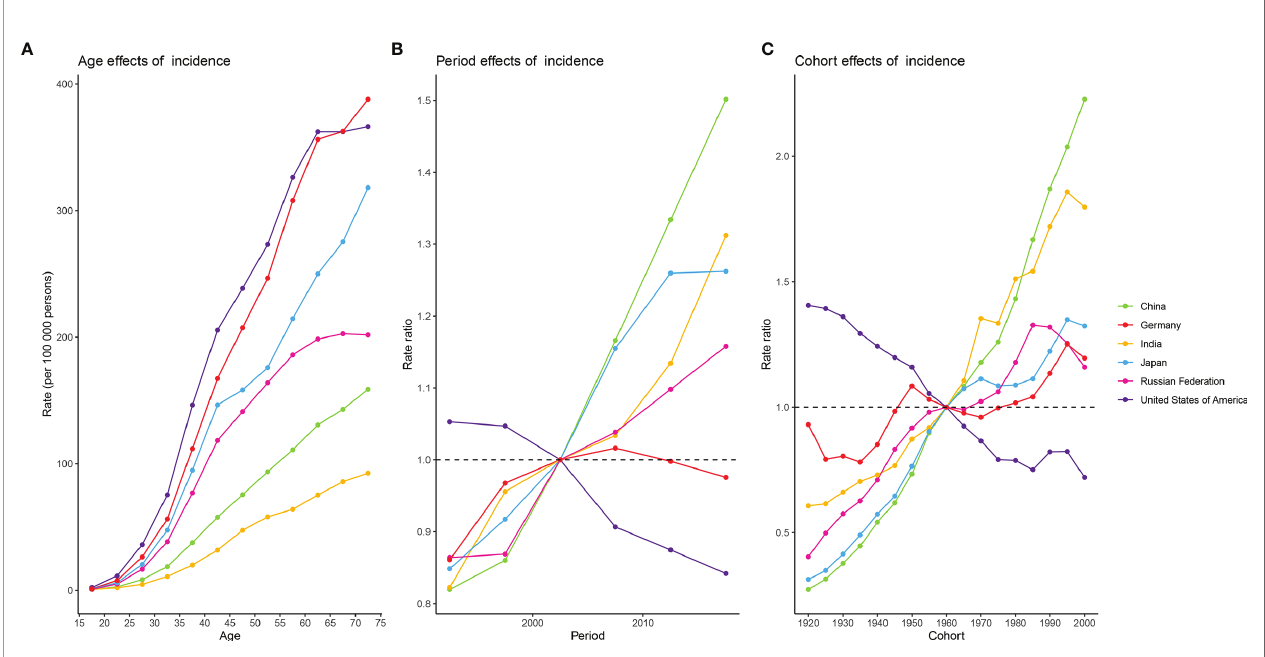
FIGURE 4 | Estimates of age, period, and cohort effects on the incidence of female breast cancer in the six burdensome countries from 1990 to 2019. (A) age effects; (B) period effects, with period 2000-2004 (median 2002) as reference period; (C) cohort effects, with cohort born in 1958-1962 (median 1960) as reference birth